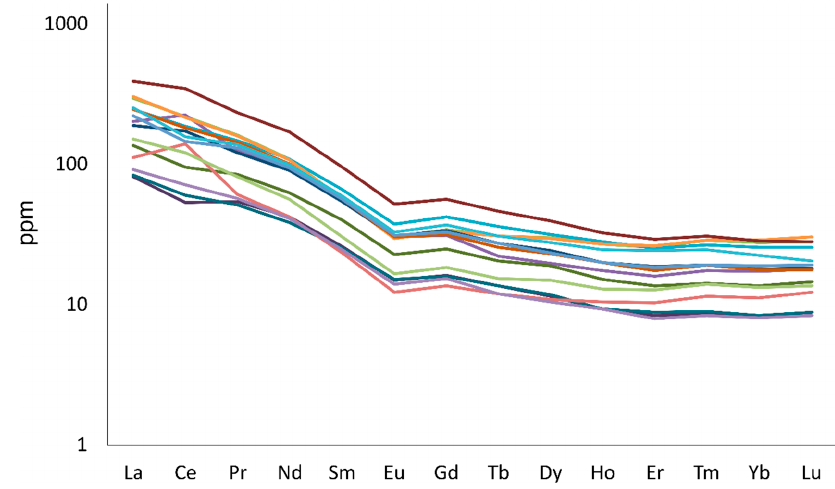
Figure 8. Chondrite-normalised REEs patterns of studied